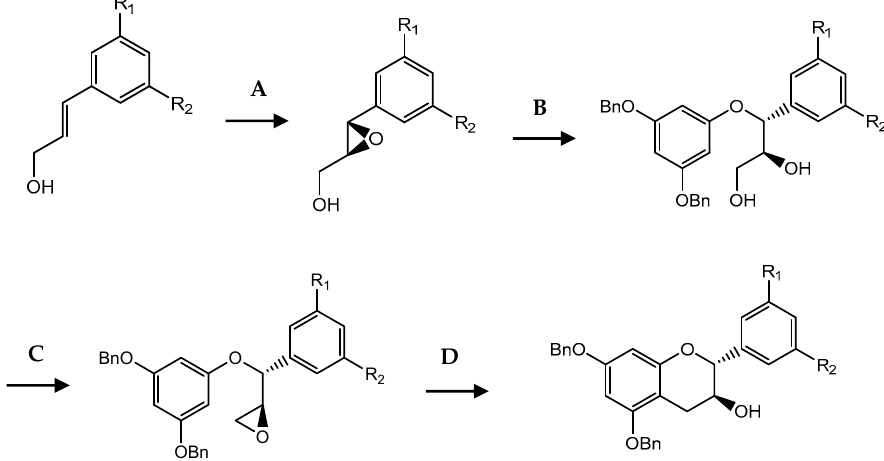
Figure 21. Flavanols synthesis by Sharpless epoxidation. ( A ) Diethyl-L-tartrate, Ti(Por) 4 , t -BuOOH; ( B ) 3,5-Dibenzoxyphenol, NaH, THF, H 2 O; ( C ) Pyridine, p -tosyl chloridre, r.t, 2 d then K 2 CO 3 ; ( D ) HFIP, reflux. Adapted from